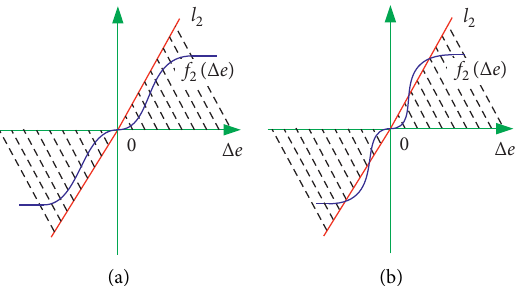
Figure 10: Relationship between l 2 and the nonlinear feature curve of PCL system. (a) Absolute stability system. (b) Unstable